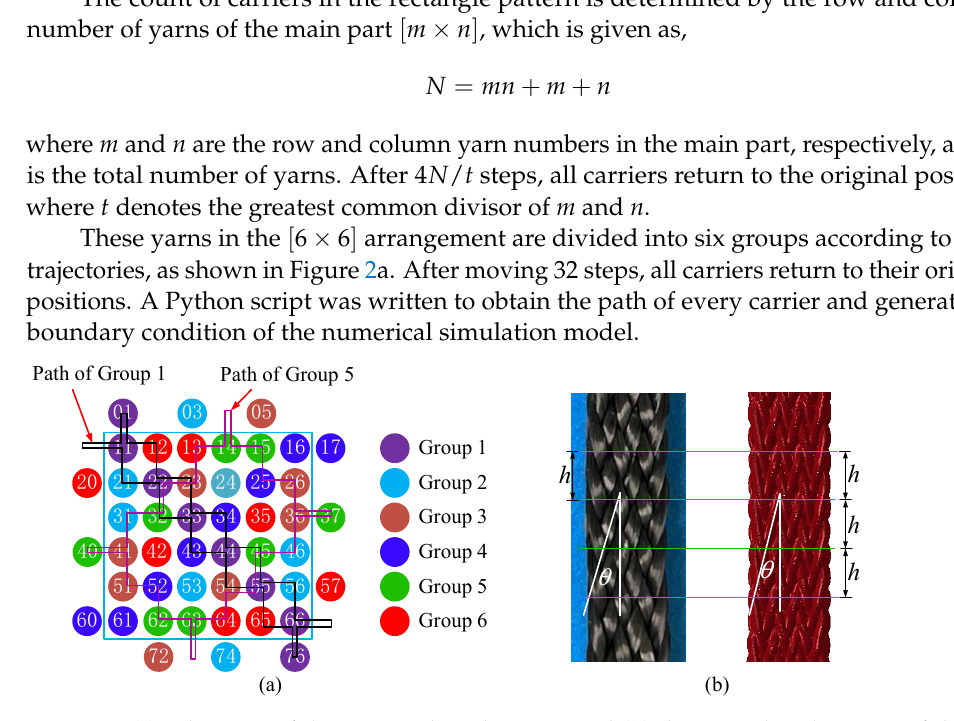
Figure 2. ( a ) Schematic of the yarn path and groups and ( b ) the 3D4D braid pattern of the test specimen and the simulation results.